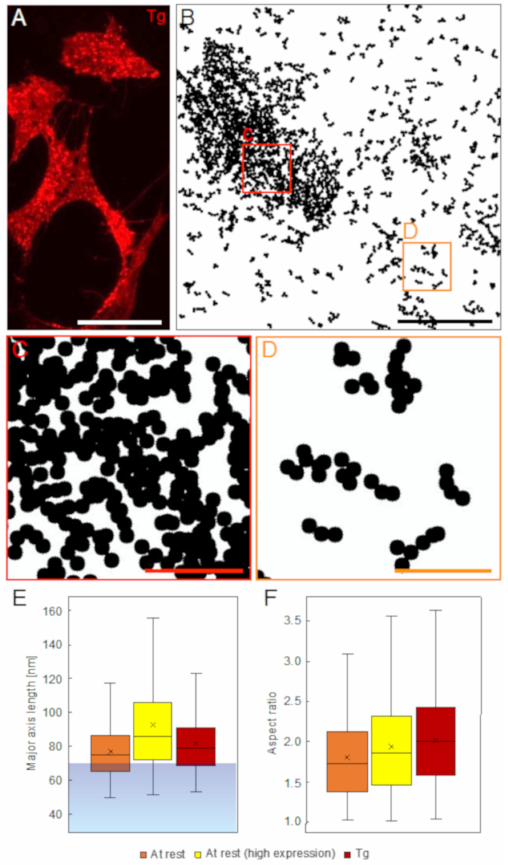
Figure 3. ORAI1 distributions 15 min after Thapsigargin (Tg) in maximally SOCE-activated cells (expressing ORAI1 and STIM1 in a 1:3 ratio). ( A ) Fluorescence microscopy image showing the QD signal. The non-homogeneous distribution of QD fluorescence into bright dots indicates the assembly of ORAI1 in puncta. ( B ) Cluster analysis of a STEM image recorded after maximal SOCE- activation, showing all clusters >2. A densely ORAI1 filled ellipsoid area is visible on the left side, surrounded by more loosely scattered elongated clusters. ( C , D ) show the boxed regions in ( B ) in more detail. The clusters found within the dense region ( C ) are so condensed that their elongated shape can only partially be recognized (mainly in the lower left area). ( D ) Shows the cluster distribution outside of the dense region where the high aspect ratios of the clusters emerge more clearly. ( E ) Quantitative results showing box plots for the measured length of the major axis length of all entirely displayed clusters >2 detected in STEM images from cells at rest showing low expression (orange) (436 clusters, average density = 62 labels/ µ m 2 ), high expression (yellow) (1.548 clusters, average density = 242 labels/ µ m 2 ), and from regions outside the puncta in maximally Tg activated cells with low expression (red) (277 clusters, average density = 53 labels/ µ m 2 ). The corresponding percentile values of the distribution of the label density, were 13%, 84%, and 8%, respectively. In all three experimental groups, the vast majority of the clusters are longer than 70 nm, which is the maximum range for QDs attached to the same ORAI1 hexamer (represented by the transparent blue region < 70 nm in the plot). ( F ) Determination of the aspect ratio for all clusters >2, reveals similar values in resting low and high expressing cells and in maximum Tg activated cells outside the puncta. Scale bar in ( A ) = 50 µ m, in ( B ) = 1 µ m, and in ( C , D ) = 200